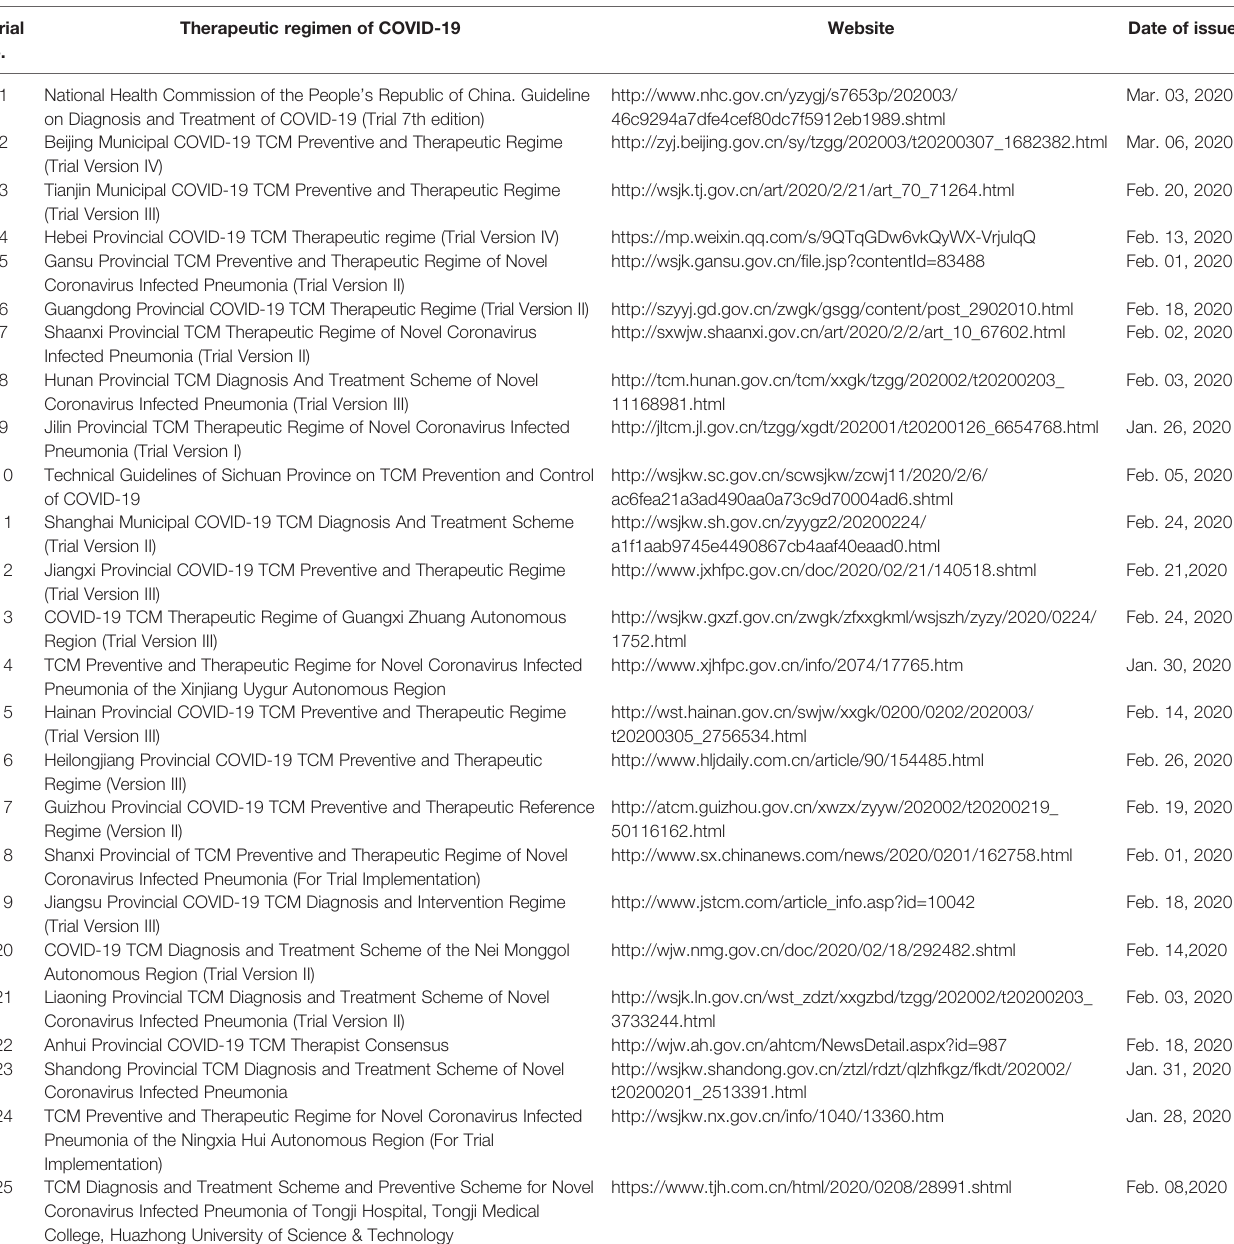
TABLE 1 | Therapeutic regimens for COVID-19 in China. Serial Therapeutic regimen of COVID-19 No.